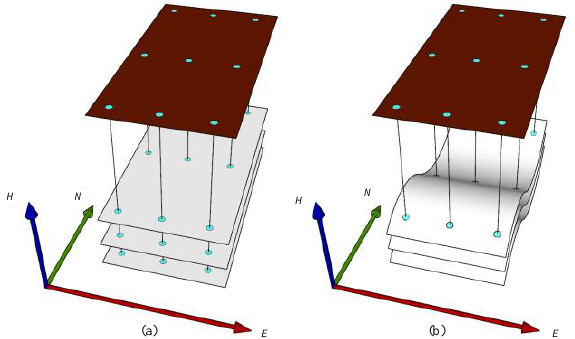
Figure 1. (a) The standard RPC fitting method generates the virtual ground control points from uniformly distributed horizontal planes between the height range. (b) The proposed RPC fitting method in Planetary3D generates the points according to the terrain surface. This will improve the fitting performance when the image covers a vast area and the height is spanning a large